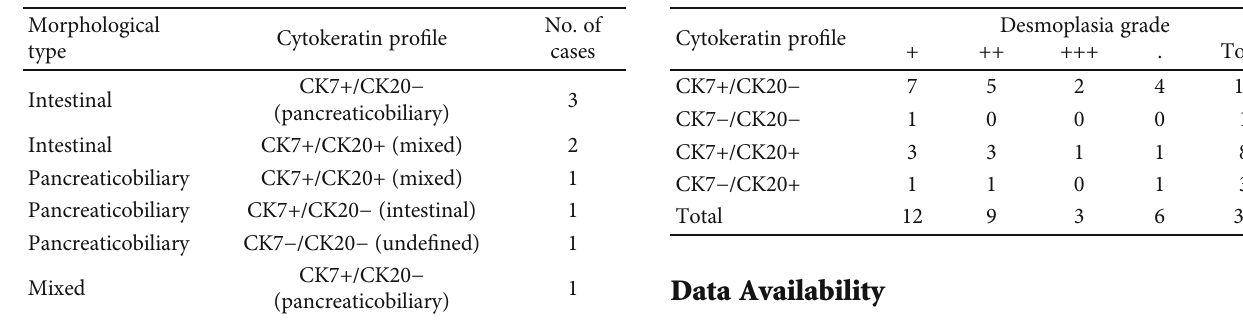
Table 5: Number of cases by desmoplasia grade and cytokeratin pro fi